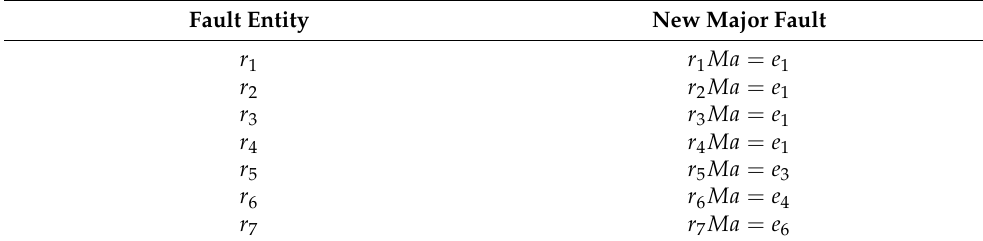
Table 3. Results of updating the major fault labels.